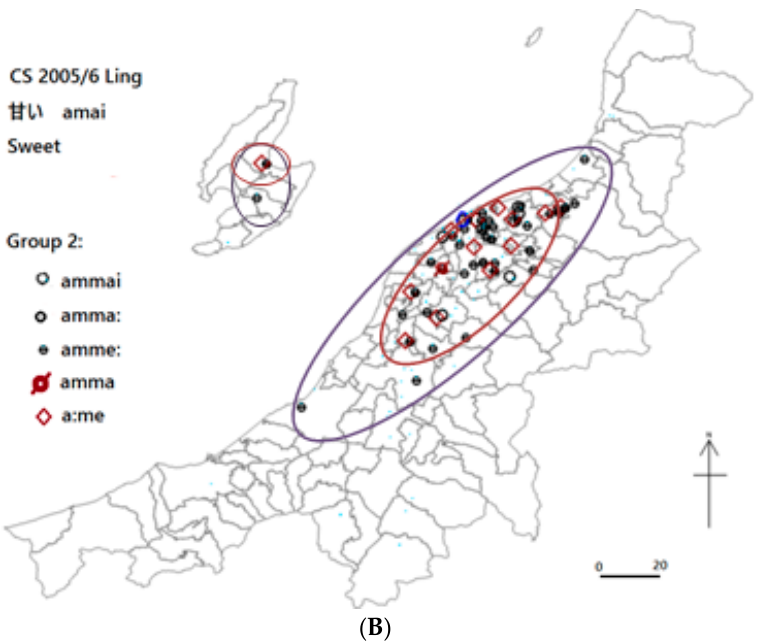
Figure 3. ( A ) Map (Group 1) of amai “sweet” in Niigata: 2005/6 CS Survey. ( B ) Map (Group 2) of amai “sweet” in Niigata: 2005/6 CS Survey.